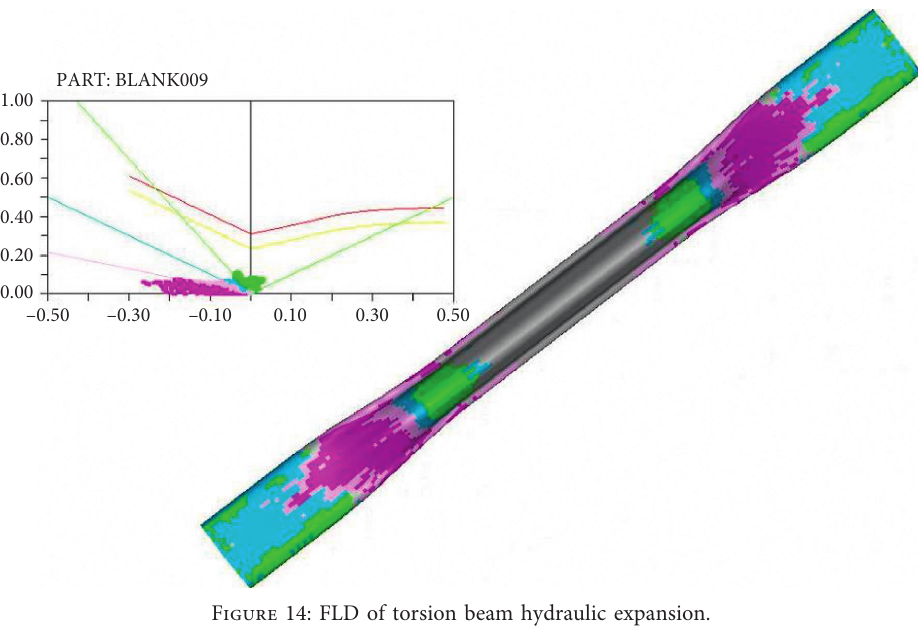
Figure 14: FLD of torsion beam hydraulic expansion.